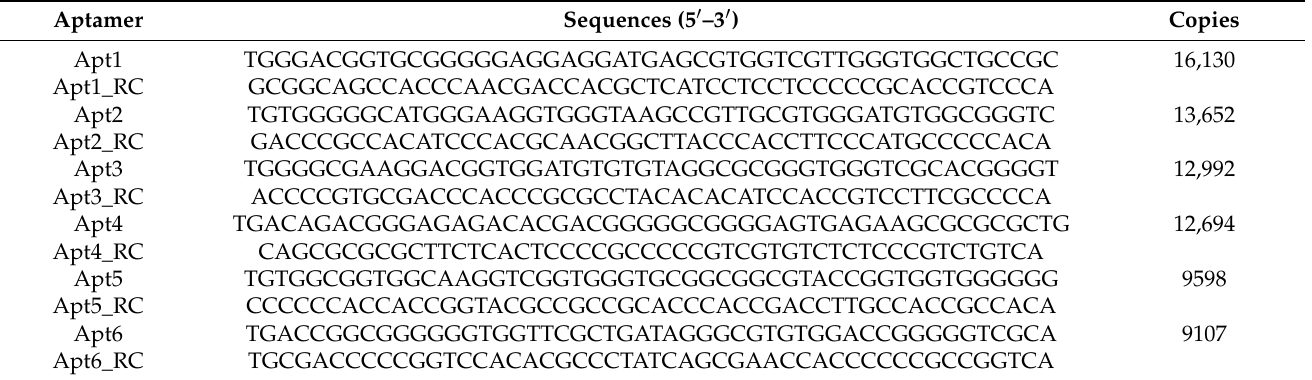
Table 2. Selected aptamer sequence candidates. Ten most repeated aptamer sequences and their reverse complement (RC) sequences obtained after next-generation sequencing (NGS) of the final (8th) cell-SELEX cycle. Only the random region part of sequences is